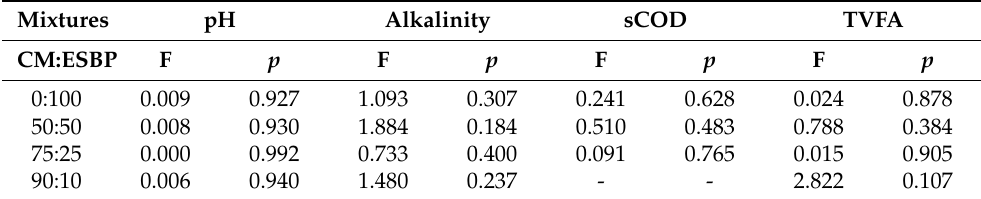
Table 3. Statistical analysis.